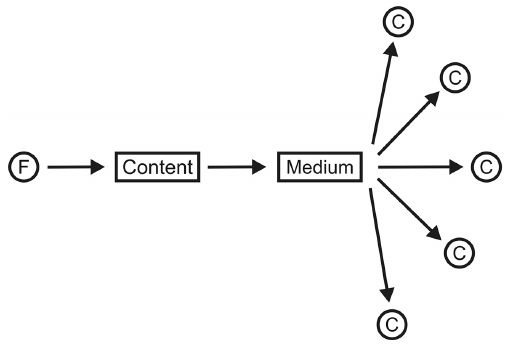
Figure 1. Traditional one-to-many model of mass communication (source: Hoffman & Novak, 1996)